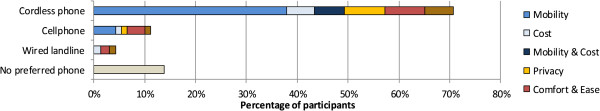
Short title: Preferred phone for long calls made at home, with reasons. Legend: Cordless phones were by far the most popular for long calls from home. Participants provided reasons for their choice of favourite phone from which the categories shown in the legend were compiled. Mobility was the most important reason. For many, this was to allow them to do something else at the same time. N=369.